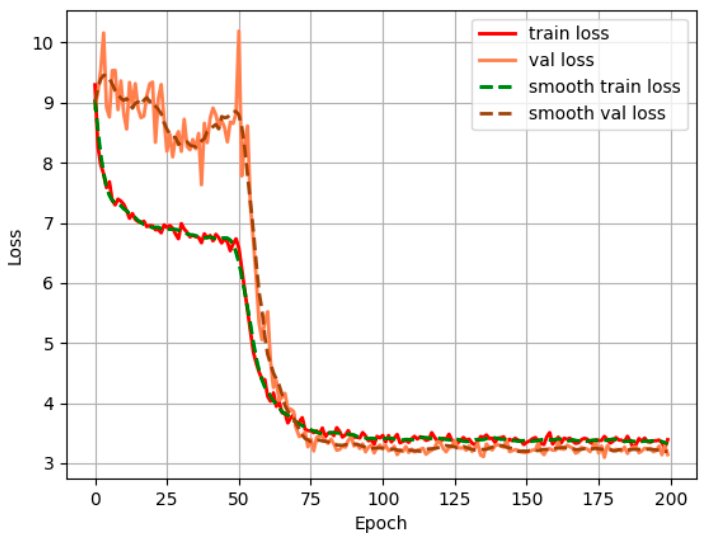
Figure 10. Scaling curve of network loss function.